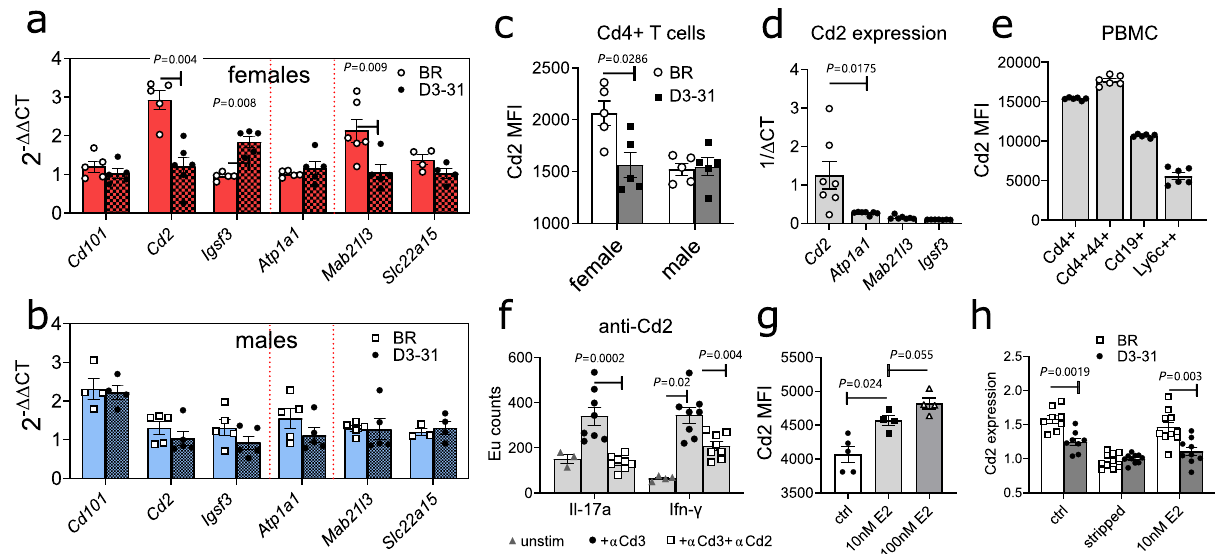
Fig. 5 D3-31 mice show sex-speci fi c differences in Cd2 expression. a , b Expression of genes surrounding the D3-31 congenic fragment in lymph nodes cells. Expression data for female mice is shown in a (red), and for male mice in b (blue). Dotted red lines indicate congenic fragment borders. c Cd2 protein expression in lymph node Cd4 + T cells from female and male D3-31 and BR mice ( fl ow cytometry). Data in a – c is representative of three independent experiments with similar results. d Expression of Cd2 and other surrounding genes in lymph node cells from BR mice. e Cd2 protein expression in blood T cells, B cells and monocytes ( fl ow cytometry). f Secretion of Il-17a and Ifn- ƴ in T cells stimulated with soluble anti-Cd3 mAb only, or soluble anti-Cd3 and soluble anti- Cd2 mAb. g Cd2 expression in lymph node T cells after in vitro culturing with increasing concentrations of 17- β -estradiol (E2). Data in d – g is representative of two independent experiments with similar results. h Comparison of Cd2 expression in T cells from D3-31 and BR mice cultured in normal medium (ctrl), charcoal-stripped medium devoid of E2 (-E2), or -E2 medium supplemented with 10nM E2. Data in h is pooled from two independent experiments. In all fi gures, each dot represents one independent mouse biological replicate. Data are summarised as mean (SEM). Statistical signi fi cance was evaluated using a two-tailed non-parametric Mann – Whitney U test. Sequential fl ow cytometry gating strategies for c and e are provided in Supplementary fi g.